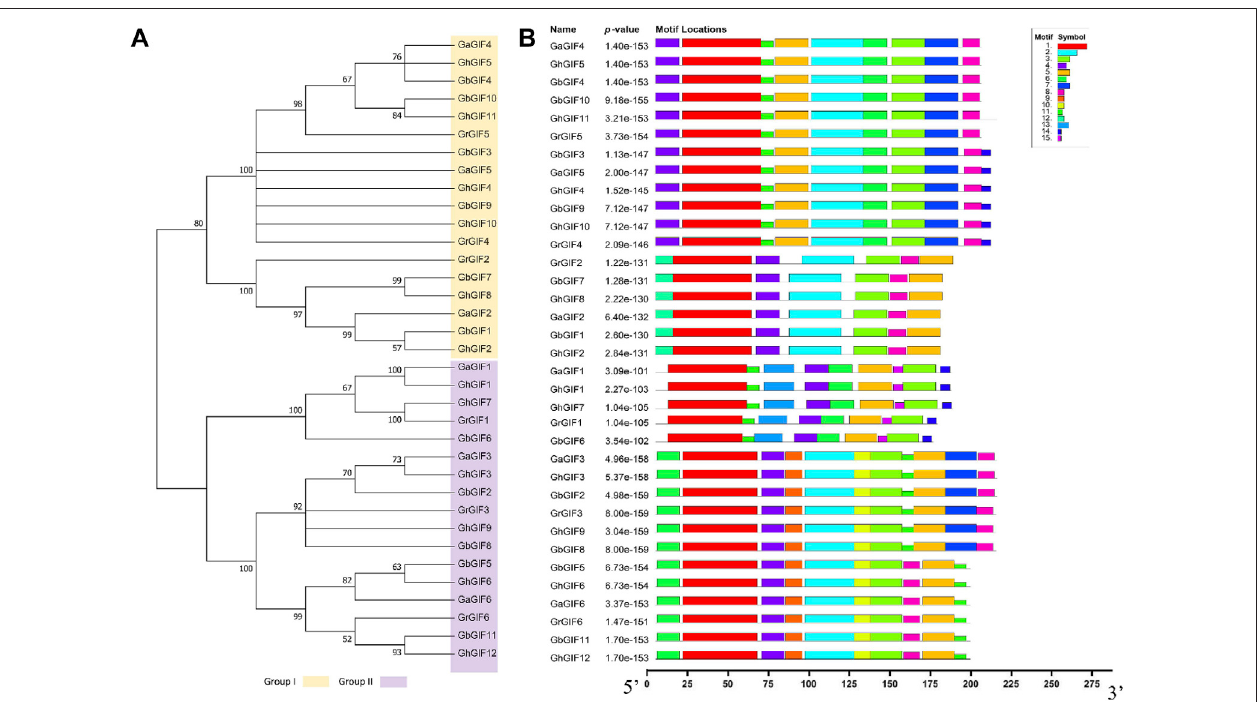
FIGURE 2 | Phylogenetic and conserved motif analysis of GIF genes in Gossypium . (A) phylogenetic tree (B) The 35 GIF genes have 15 conserved motifs.